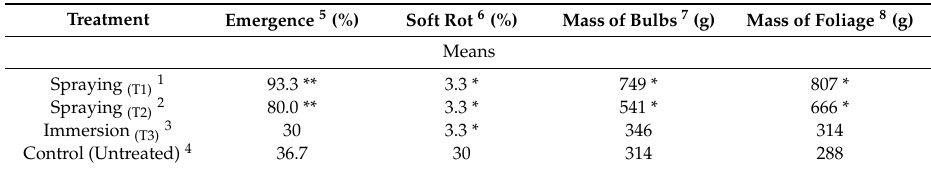
Table 5. Means of treatments in the persistence